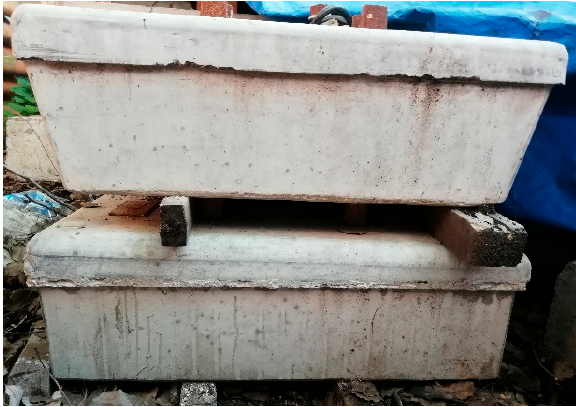
Figure 8. Full-scale model of TLVT and ILVT supporting block.